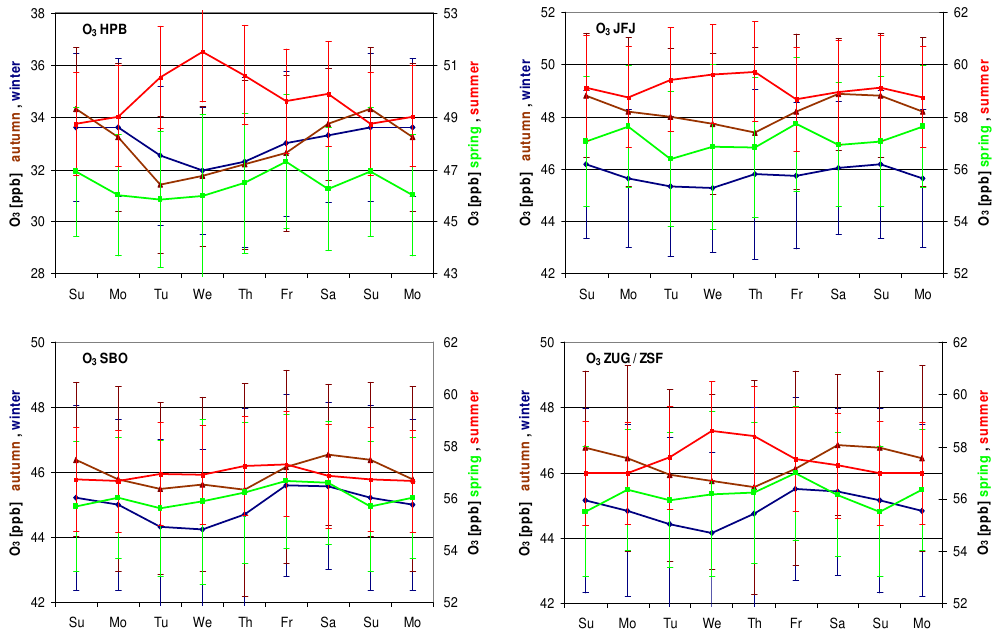
Fig. 6. Weekly variation of O 3 for the different seasons at the respective “DACH” sites; blue: winter, brown: autumn (left axis), red: summer, green: spring (right axis). The errors bars indicate the standard error of the mean.